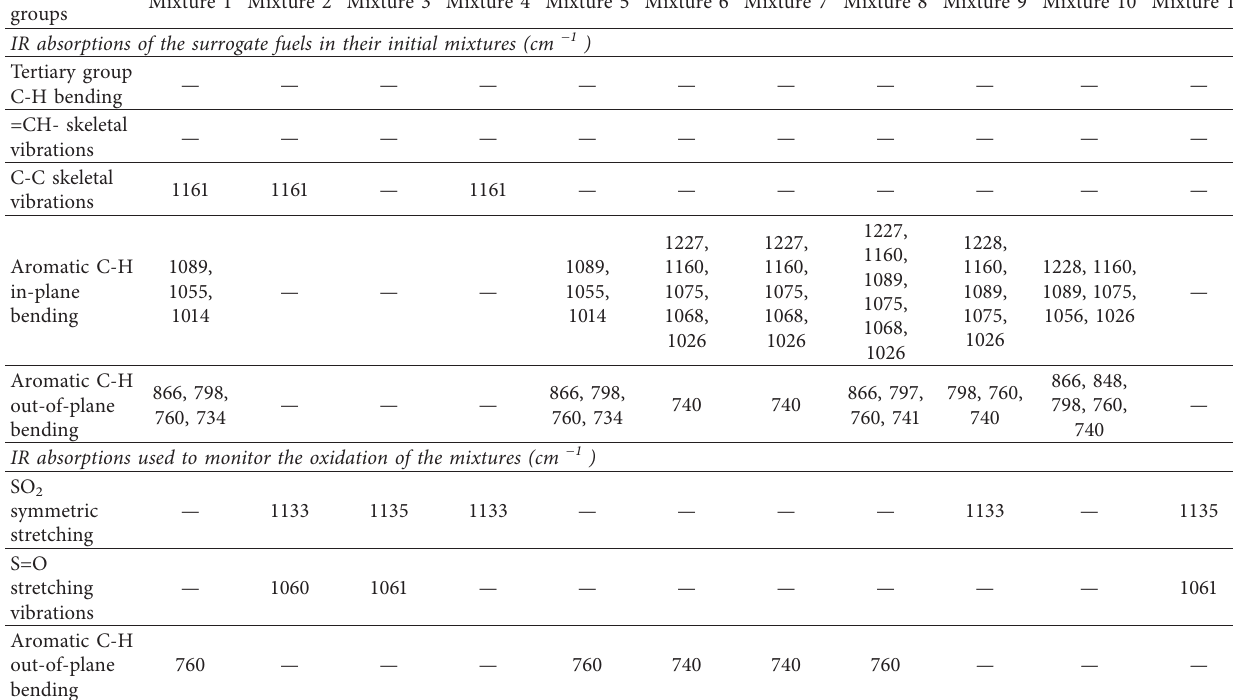
Table 5: IR absorptions of the surrogate fuels in their initial mixtures and during their oxidation. Characteristic groups that contribute to the monitoring of the oxidative process. The absorptions of the solvent, n-hexadecane, were excluded. Characteristic groups